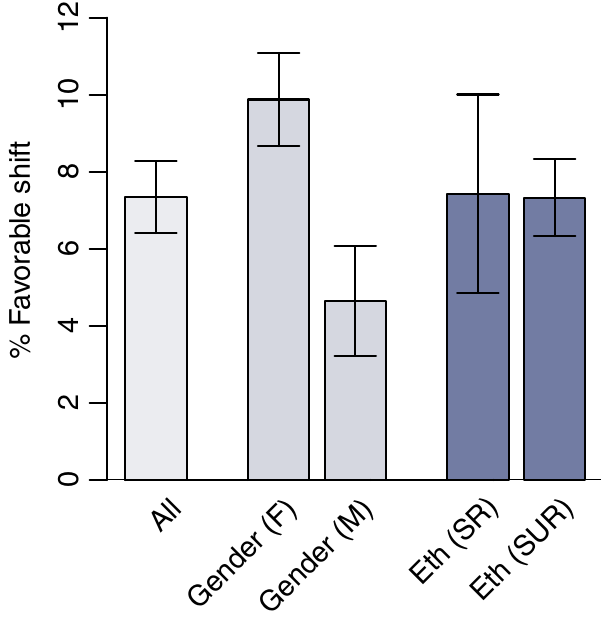
FIG. 2. Average shift in overall favorable percentage CLASS score, with bars showing standard error of the mean. Shifts are shown overall and then disaggregated by gender (male or female) and ethnic representation (statistically represented or statistically underrepresented).